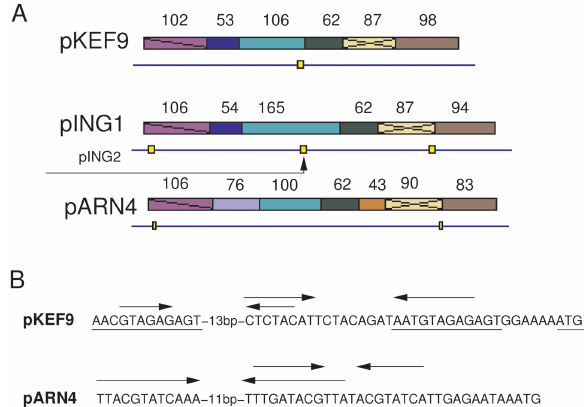
Figure 4. (A) Putative replication operon from pKEF9, pING1 and pARN4. Homologousopen readingframes(ORFs)areshown iniden- tical colors and the ORF sizes are given. Positions of the recombina- tion motifs are indicated by yellow boxes on the linear genomes. The region of the operon present in the deletion derivative pING2 is mapped below pING1. (B) Promoter regions for the regulatory site of the putative CopG homolog on pKEF9 and pARN4 are aligned. The start codon of the first gene in the operon is underlined in red. Inverted repeats are marked by arrows. Direct repeats are underlined.